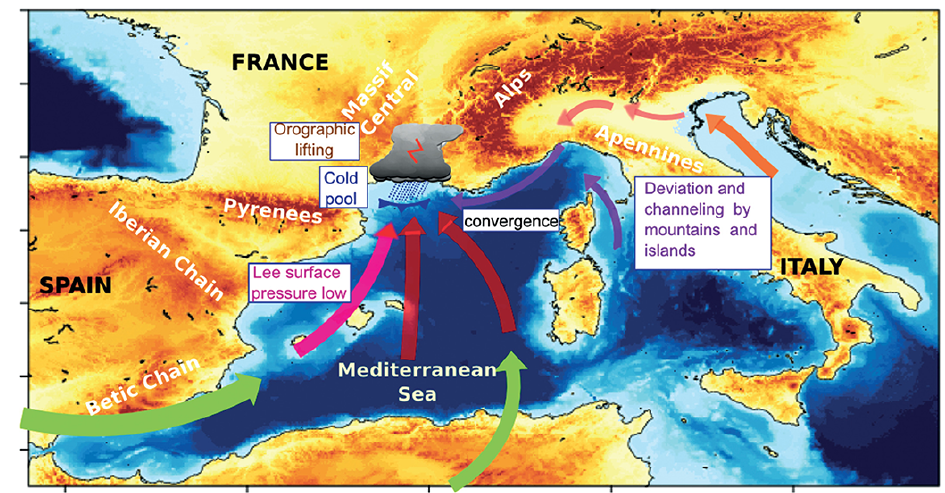
Figure 2. Schematic of the main low-level mechanisms responsible for a sample case of a HPE in the western Mediterranean region together with geographical locations (from Ducrocq et al.,